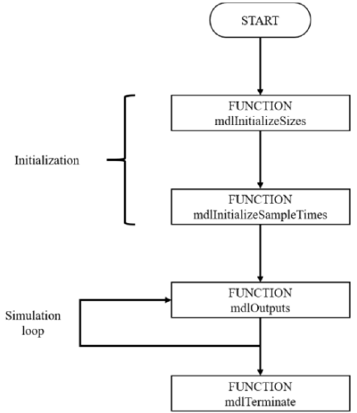
Figure 5. Logic flow diagram of developed system-function and shared memory block. Table 2. List of variables for monitoring and evaluation of the SMR catalyst.